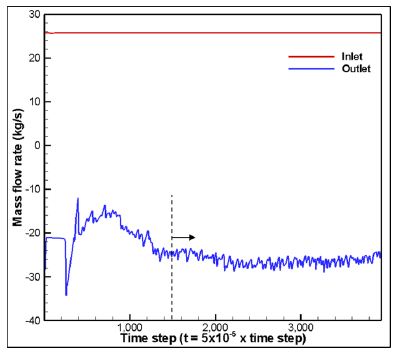
Figure 11. Time histories of mass flow rates for large eddy simulation (LES).